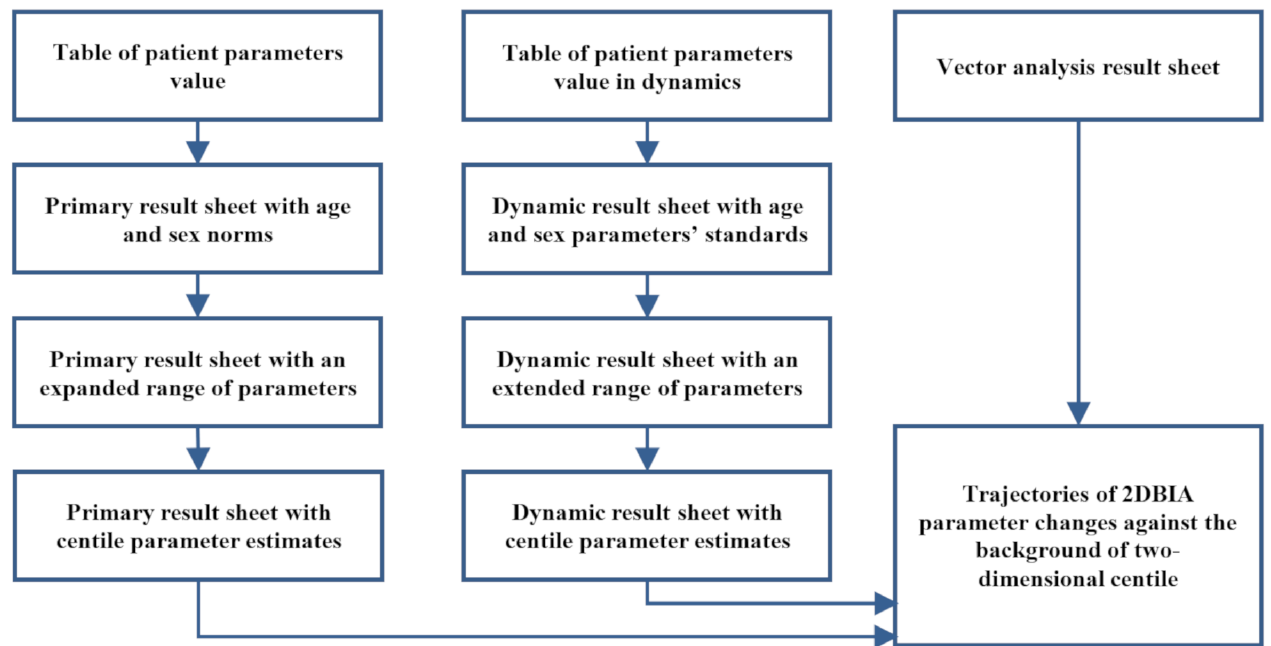
Fig. 1. Main stages of the BIA result sheets presentation